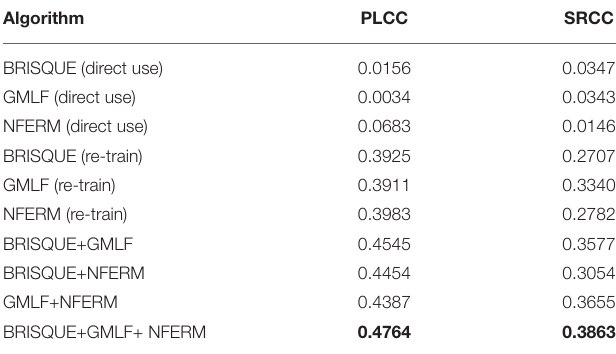
TABLE 1 | The Pearson linear correlation coefficient (PLCC) and Spearman rank order correlation coefficient (SRCC) values of seven feature fusion methods on the